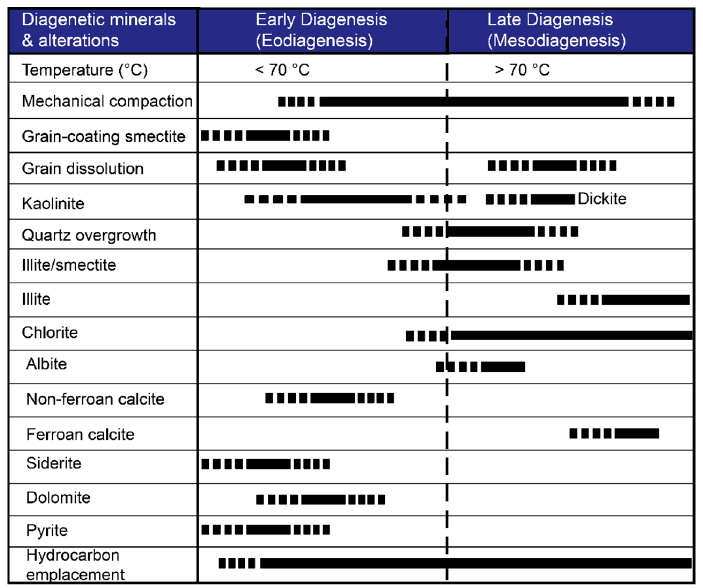
Figure 12. Paragenetic sequence for the Forties sandstones showing the sequence of diagenetic events.